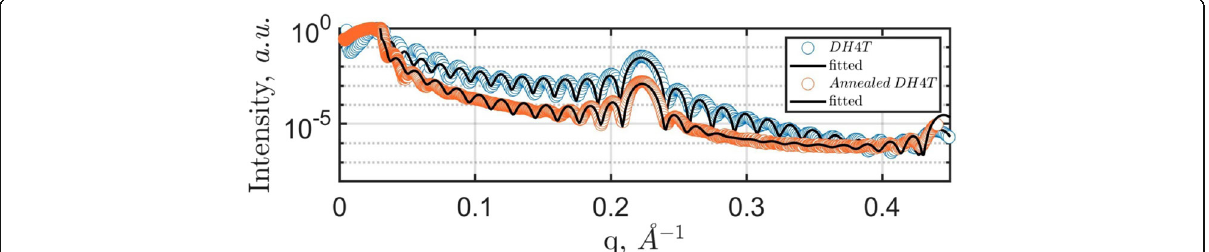
Fig. 6. Room-temperature XRR curves of a DH4T film before and after annealing. The dwelling time of the annealed film at room temperature was a